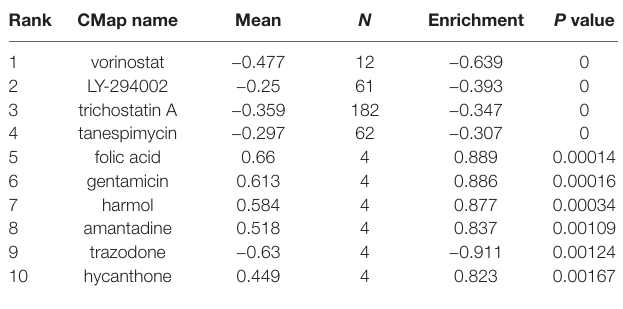
TABlE 1 | Results of ConnectivityMap (CMap) analysis.